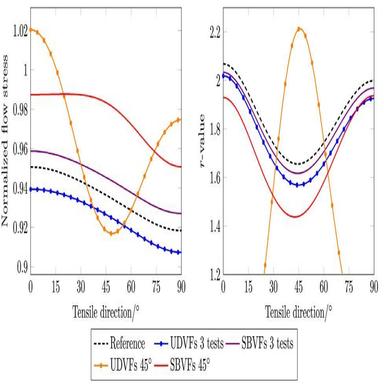
Comparison of identified flow stress curves at 0∘ orientation.